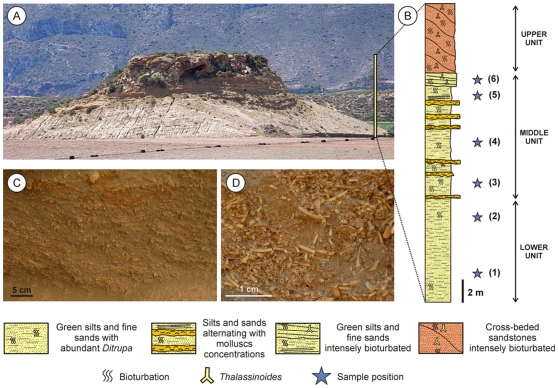
Stratigraphy and biostratinomy of the Cabo Cope outcrop.(a) A panoramic view of the northwestern wall of the outcrop; (b) A schematic stratigraphic column of the three informal units distinguishable in the outcrop (stratigraphic position of samples indicated with stars); (c) A close-up of matrix-supported skeletal accumulations dominated by abundant tubes of Ditrupa arietina (Lower Unit); (d) A close-up of a monospecific concentration of D. arietina (Middle Unit).